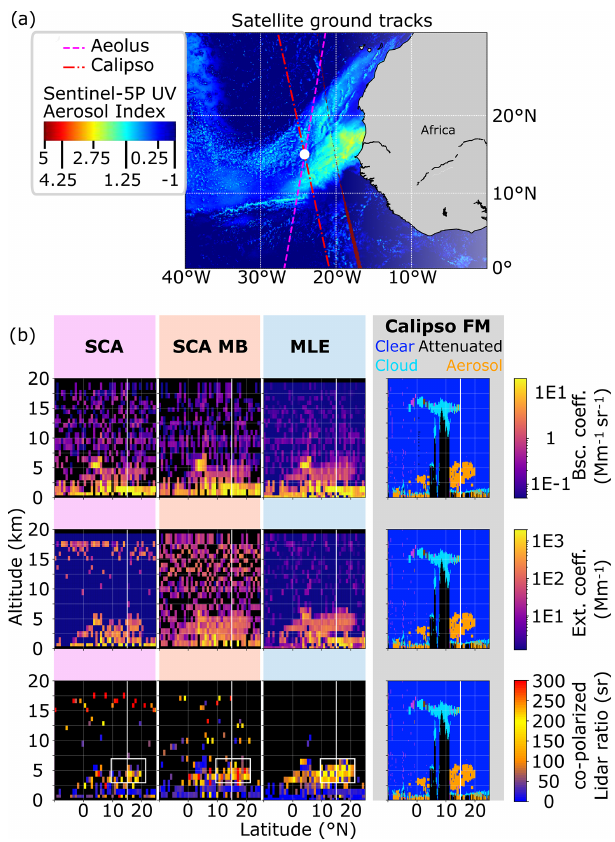
Figure 6. Real data case I: (a) map of Africa’s east coast over- laid with the ground tracks of the Aeolus satellite between 07:30 and 07:40UTC (pink, dashed) and the CALIPSO satellite between 15:20 and 15:30UTC (red, dash-dotted). Overlaid in colour is the Sentinel-5p UV aerosol index from 388 and 354nm spectral bands. (b) Optical property processing results for the extended desert dust plume (Saharan Air Layer, SAL) from 30 June 2020 for the dif- ferent algorithms. Columns in panel (b) (from left to right) are the SCA, SCA midbin and MLE. The rows show backscatter (first row), extinction (second row) and lidar ratio (last row). The CALIPSO vertical feature mask (VFM) is repeated in each row. Aeolus and CALIPSO ground tracks cross at the white line. For better inter- pretability, the lidar ratio is only shown where the corresponding backscatter coefficients exceed 0.25Mm − 1 sr − 1 , and extinction co- efficients exceed 3.75Mm − 1